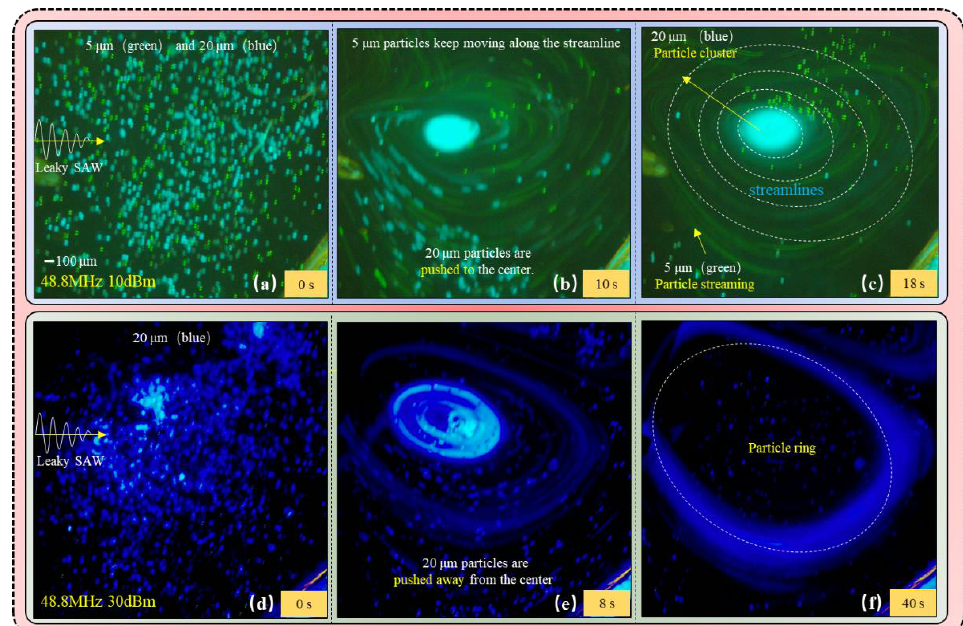
Figure 4. ( a – c ) Describes the formation process of 5 μm Particle Streaming and 20 μm Particle Cluster at 48.8 MHz, 10 dBm. The 5 μm particles tend to move along the streamlines of the ASF, but not across over to the other streamlines, forming the particle streaming. The larger 20 μm particles are driven by the ARF to move along the streamlines of the ASF from the outer streamline to the inner streamline, and gradually concentrate in the center of acoustic vortex. ( d – f ) Describes the formation process of 20 μm Particle Ring at 48.8 MHz, 10 dBm. The ARF pushes the particles to the center of acoustic vortex, but the enhanced centrifugal force pushes the particles away from the center of acoustic vortex. The F C and ARF co-dominate the ring motion of the particles.